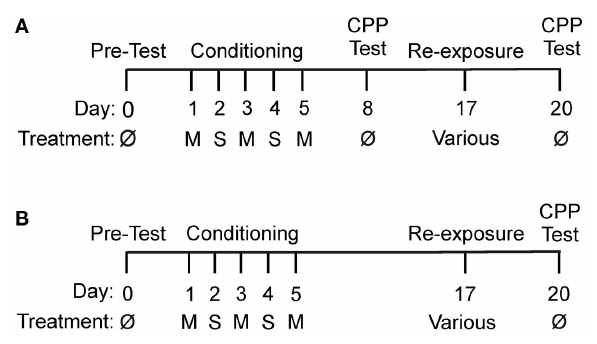
FIGURE 1 | Experimental timelines. M, methamphetamine (1mg/kg); S, saline (1ml/kg); ∅ , no drug. (A) Timeline for Experiment 1. (B) Timeline for Experiments 2 and